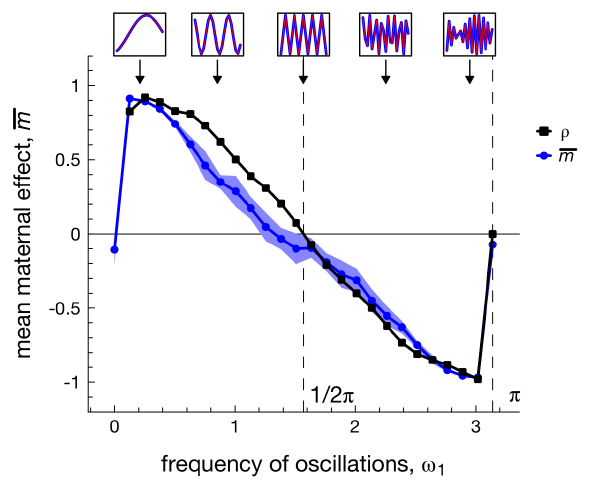
Figure 2. The evolution of univariate maternal effects for different frequencies v 1 of periodically fluctuating selection. Each dot represents the average maternal effect (cid:2) mm measured over ten replicate simulations (at generation t ~ 50000 ), while the shaded areas depict corresponding standard deviations. Boxes on the top of the graph depict the a snapshot in time of the fluctuations in the selective optimum h ( t ) over the course of 20 generations. Note that any fluctuations are absent whenever v 1 is a multiple of p , as the environment then fluctuates back towards the same state (i.e., D h =0) before selection takes place in the next generation. Black lines depict the autocorrelation r : r h ( t ), h ( t { 1) ð Þ of selective conditions between the parental and offspring generations. Parameters: m ~ 0 :